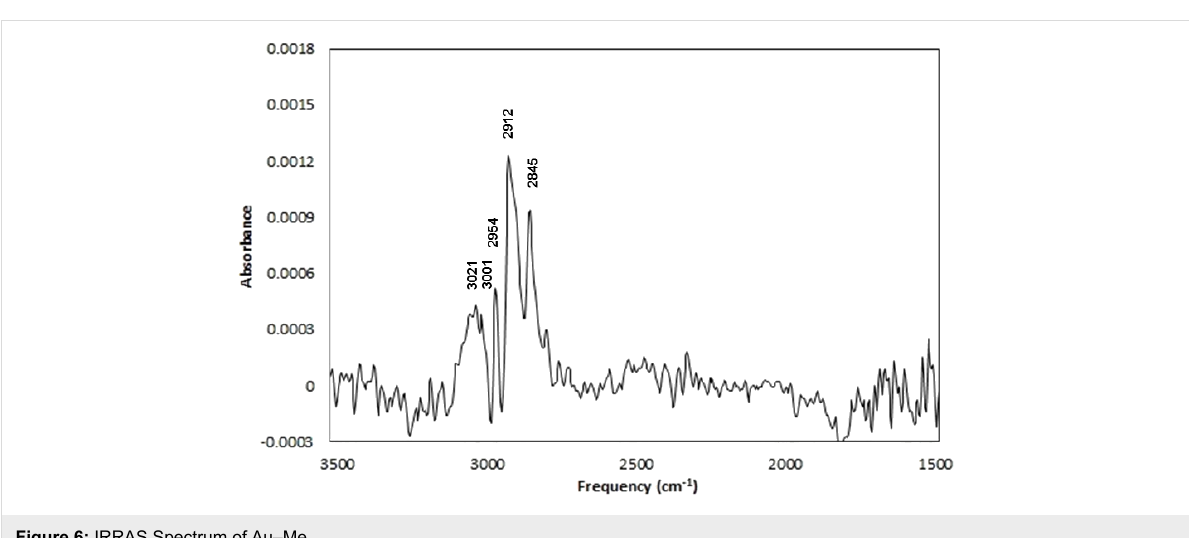
extensive, and XPS analyses (absence of nitrogen) further corroborate this assertion. Finally, IRRAS spectra with reason- able signal-to-noise ratios for Au–Me films deposited in the absence of Ru(bpy) 3 Cl 2 could not be recorded after multiple